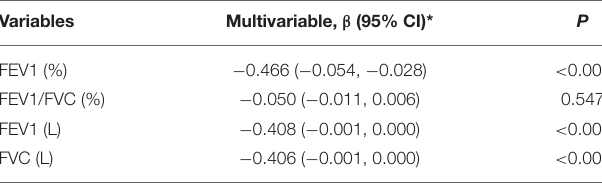
TABLE 2 | Association of serum CYR61 with lung